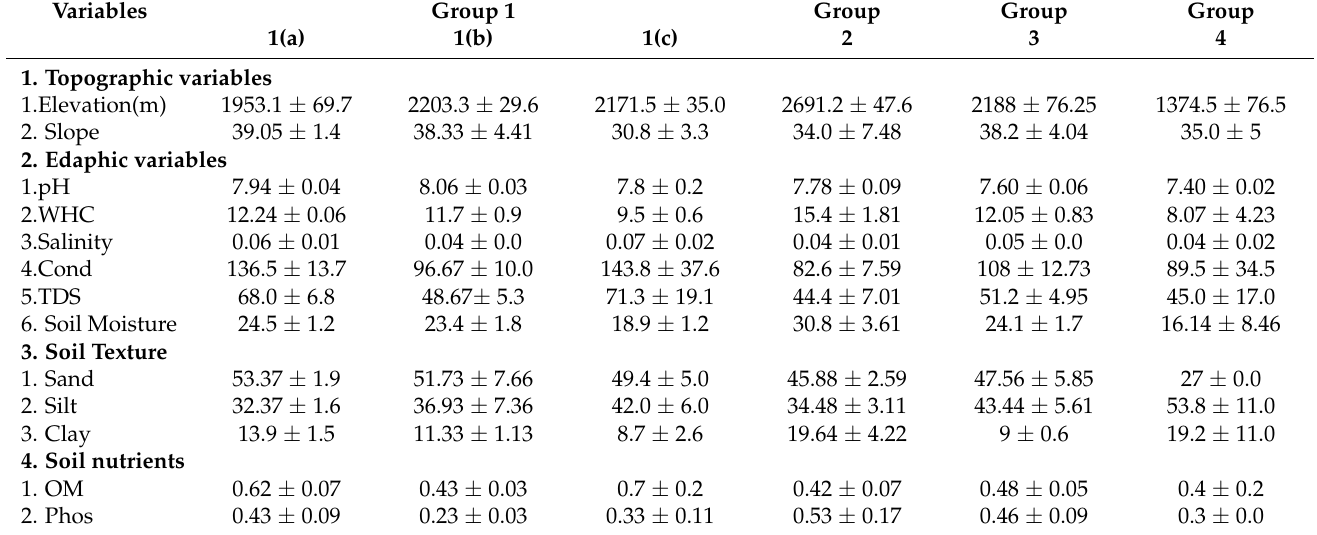
Table 2. Mean values ± SE of the environmental variables (topographic, edaphic, and soil nutrient) based on three groups derived from Ward’s cluster analysis using the tree vegetation data. (Mean ±